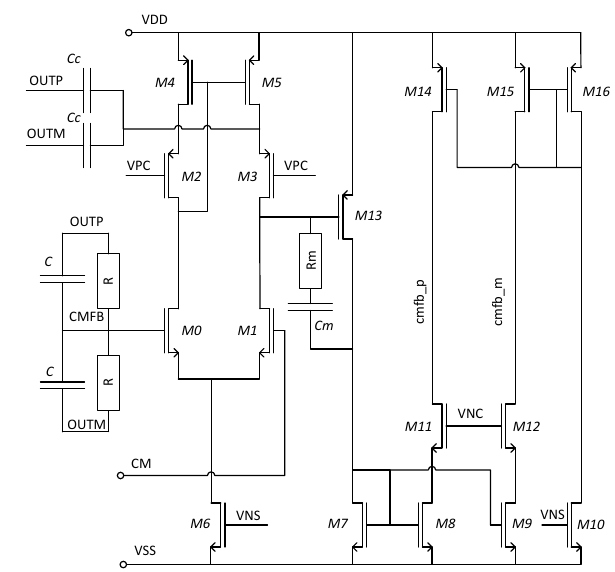
Figure 4. Architecture of the common mode